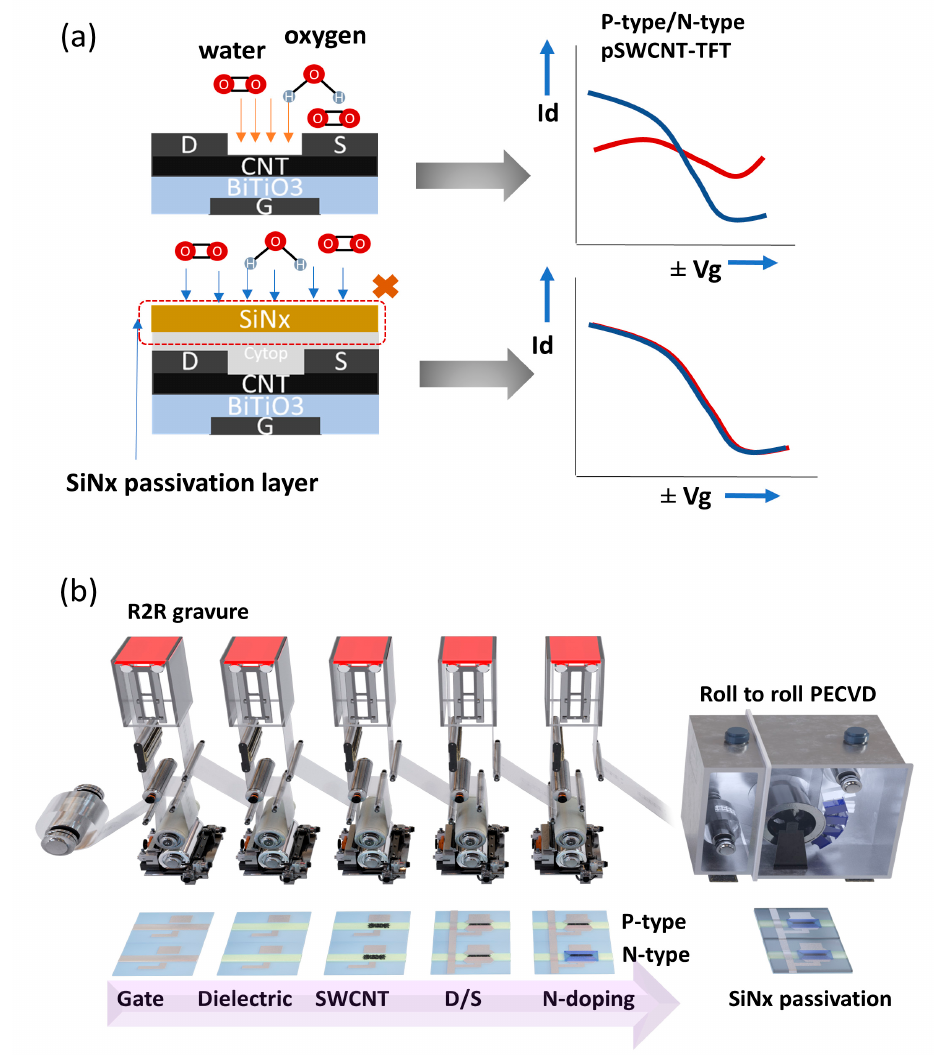
Figure 1. The overall scheme of the role of R2R gravure and R2R PECVD system to continuously deposit a SiNx passivation layer after R2R printing the pSWCNT-TFTs. ( a ) Schematic diagram showing the structure of pSWCNT-TFTs with a passivation layer to prevent the oxygen/water molecules from reaching the pSWCNT-TFT properties illustrated with transfer characteristics before (blue) and after (red). ( b ) Overall R2R gravure printing and R2R PECVD processes for manufacturing the passivated pSWCNT-TFT-based